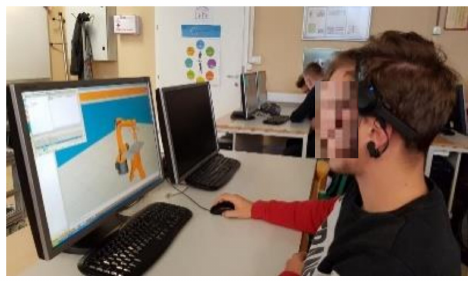
Figure 3. Lab PC problem solving